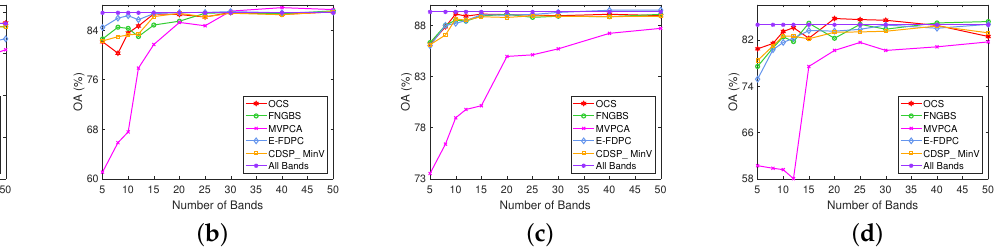
Figure 5. The OA curves of KNN on different datasets. ( a ) Indian Pines; ( b ) Pavia University; ( c ) Salinas; and ( d ) Botswana.